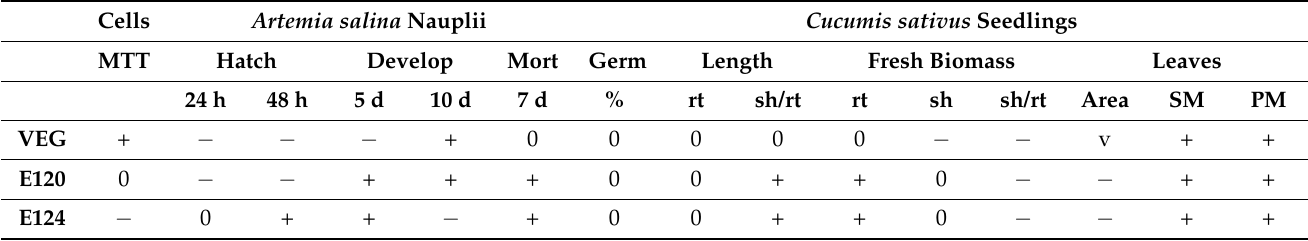
Table 1. Summary of the effects registered on in vitro cells, Artemia salina nauplii, and Cucumis sativus seedlings after exposure to vegan red VEG, E120, or E124. Values significantly increased (+), decreased ( − ), or were unchanged (0) compared to the controls ( p < 0.05). Cell viability (MTT); hatching at 24 or 48 h (hatch); developmental rate, 5- and 10-days post-hatching (develop); mortality (mort); germination (germ); root and shoot (rt, sh); thickness of spongy (SM) and palisade (PM)